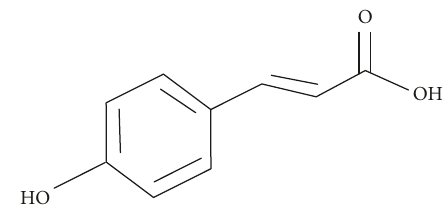
Figure 6: Chemical structure of p-coumaric acid.